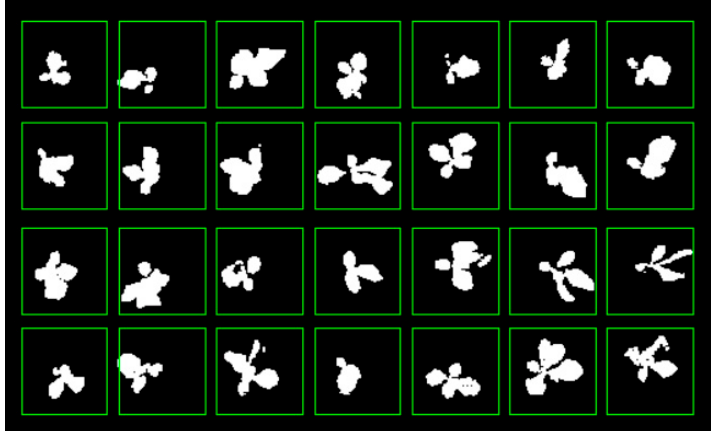
Figure 7. Image after area division.